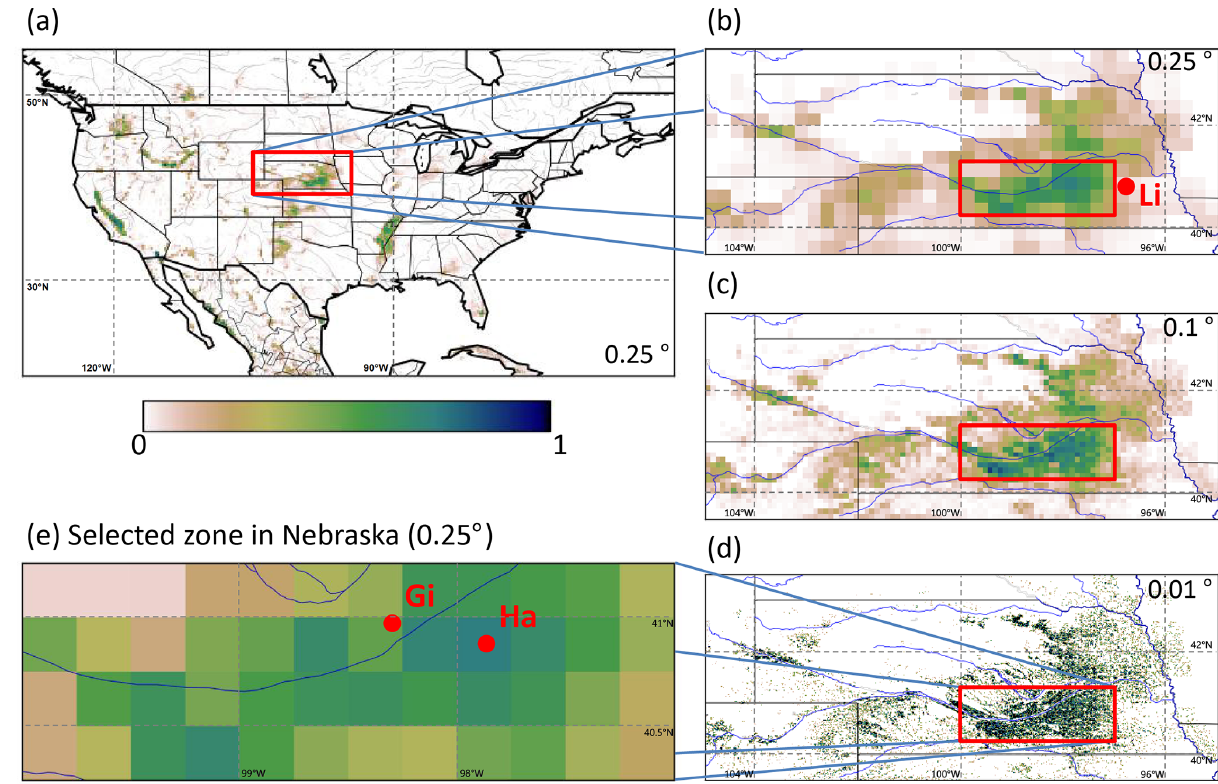
Figure 2. Irrigation fractional coverage, derived from Meier et al. (2018a), over (a) the continental United State (CONUS) and (b–e) Ne- braska, at (b) 0.25 ◦ × 0.25 ◦ , (c) 0.1 ◦ × 0.1 ◦ , and (d) 0.01 ◦ × 0.01 ◦ spatial resolutions, and (e) over the selected zone in southern Nebraska considered in this study (100–97 ◦ W, 40.25–41.25 ◦ N). The red boxes show the location of the different zooms. The Li, Gi, and Ha red dots correspond to the Lincoln weather station, Grand Island weather station, and Hampton irrigated area,